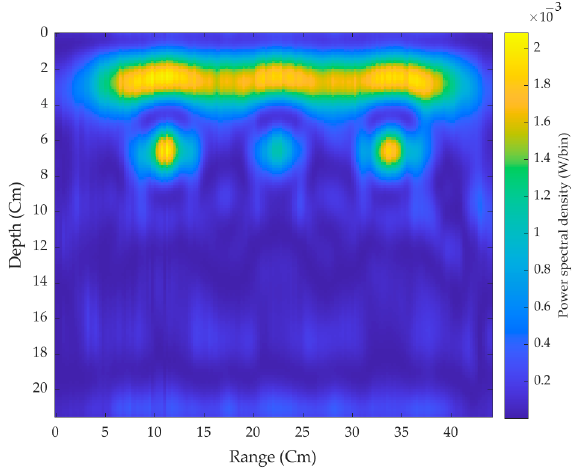
Figure 14. 2-D cross-surface scanned image with one target removed.